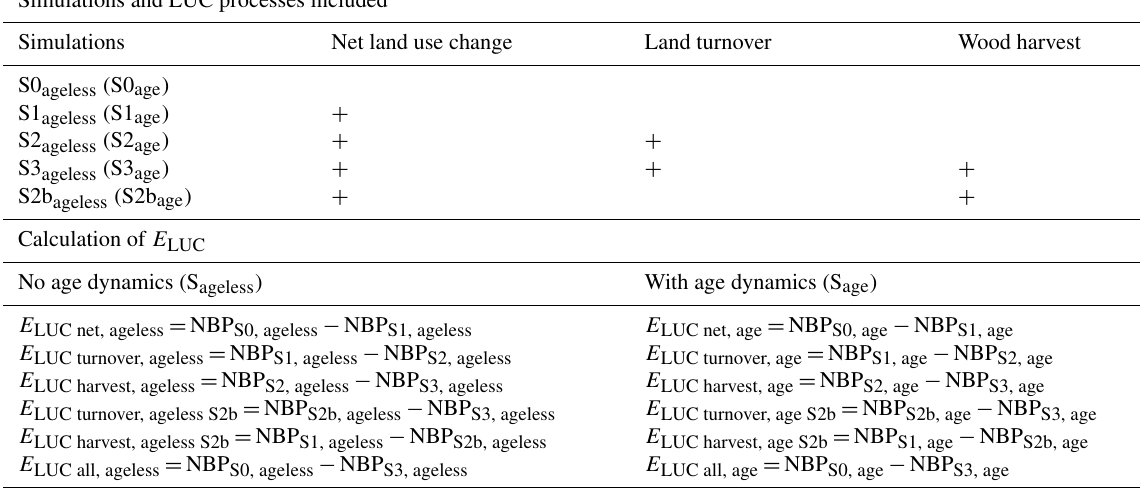
Table 2. Determination of woody biomass thresholds for different age classes of forest PFTs. We first look up through the biomass–age curve (Eq. 2) for a ratio of woody biomass to the maximum biomass that corresponds to certain ages (years), and then we multiply this ratio with equilibrium biomass at the end of spin-up for each grid cell. Numbers in the table indicate the ratio of woody biomass to the maximum woody biomass ( B max in Eq. 2), and the numbers in parentheses indicate the corresponding forest age.